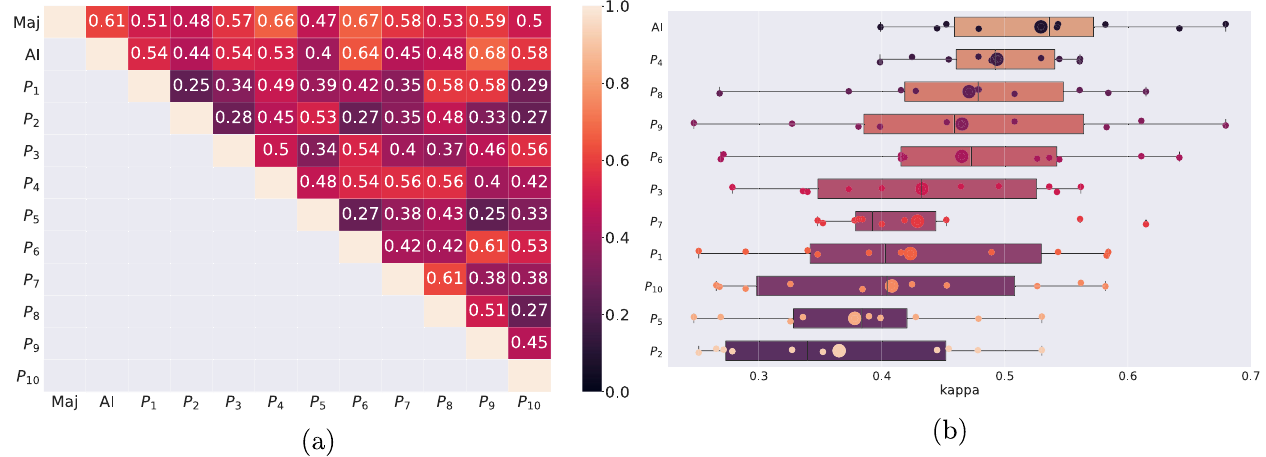
Fig. 4 Quadratic kappa scores of the pathologists as well as the AI algorithm on the evaluation set in the ROI-study (45 ROIs). In a , pairwise kappa scores of the AI algorithm and the pathologists are compared where the best pairwise kappa score was achieved between the AI algorithm and P 9 . The majority scores, denoted by Maj, had the third best kappa score with the AI algorithm, behind P 6 and P 4 . The pairwise kappa metrics, sorted by the average pairwise scores, b shows that the AI algorithm has, on average, the highest agreement out of any pathologists. It also has the highest pairwise kappa score of 0.68 with P 9 . In each row, small dots correspond to the kappa scores with the other pathologists/AI algorithm and the large dot denotes the average kappa score of that particular pathologist/AI algorithm with the